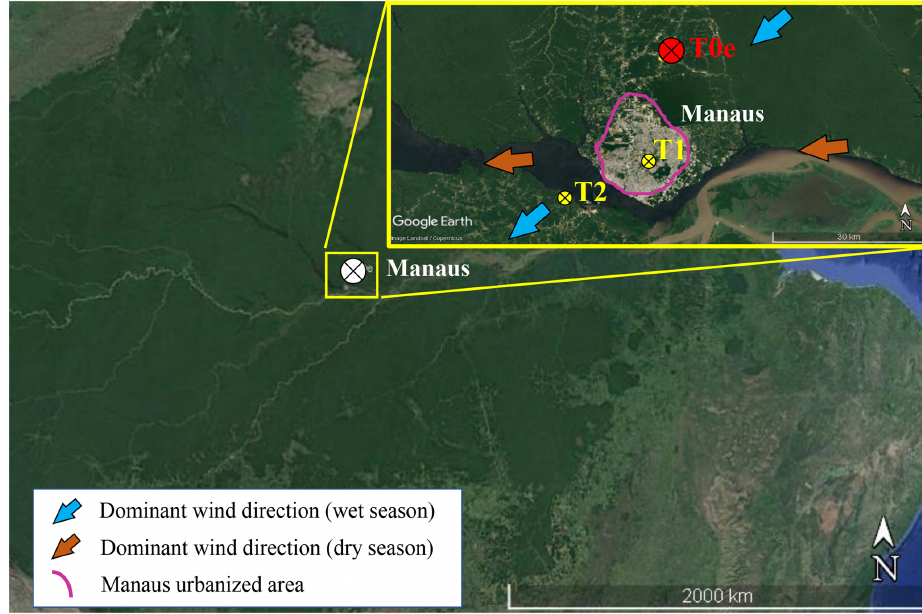
Figure 1. The T0e site location in central Amazonia from an enlarged image showing the site location upwind of Manaus. During the wet season (December to May) the dominant wind direction is from the northeast (blue arrow) and during the dry season (June to November) from the east (brown arrow). The GoAmazon2014/5 experiment sites’ relative position to Manaus: T2 is downwind, T1 is in the city, and T0e is upwind of the city (source: Google